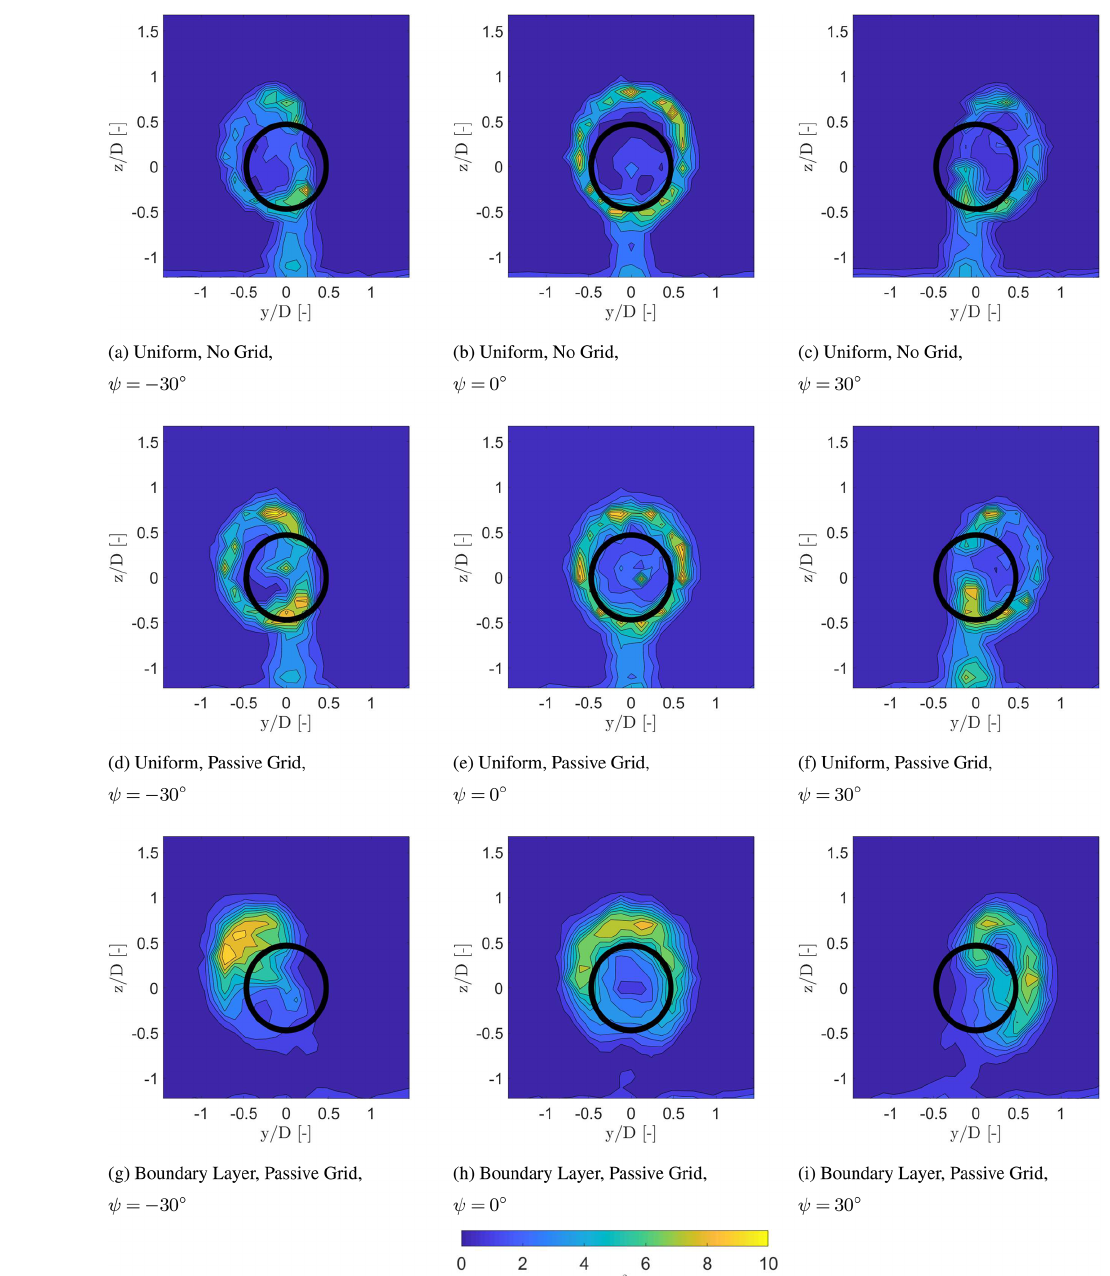
Figure 7. Energy dissipation rate within the wake at a downstream distance of 2 D for different inflow conditions. The wake is viewed looking upstream towards the turbine